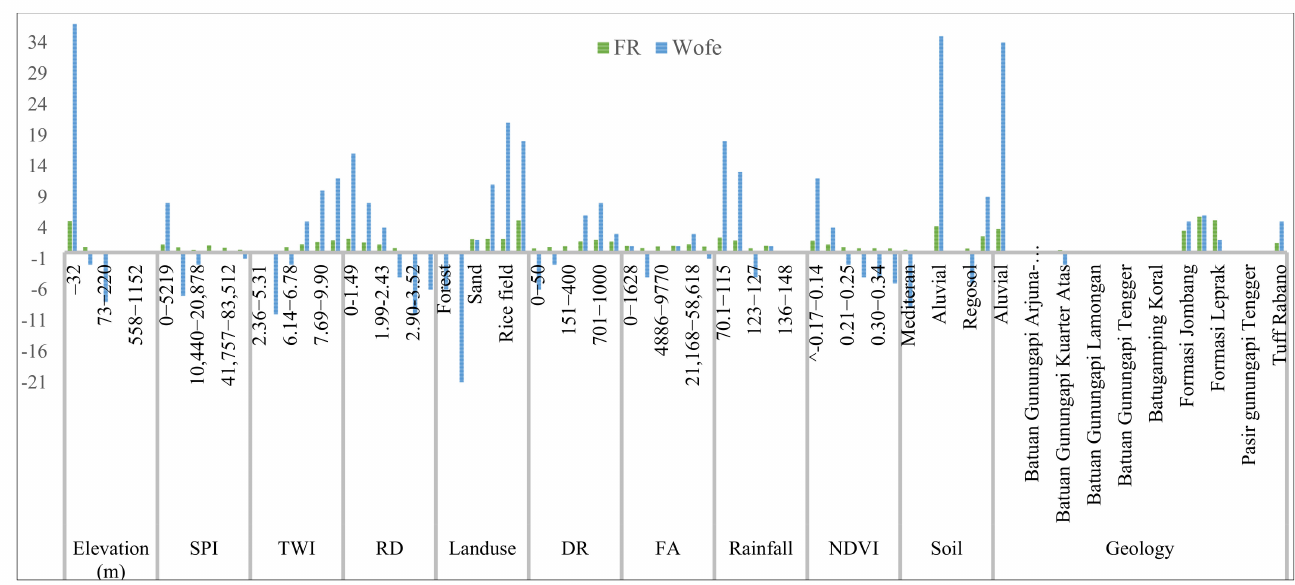
Figure 5. Summary of the 11 most important factors of each weighting